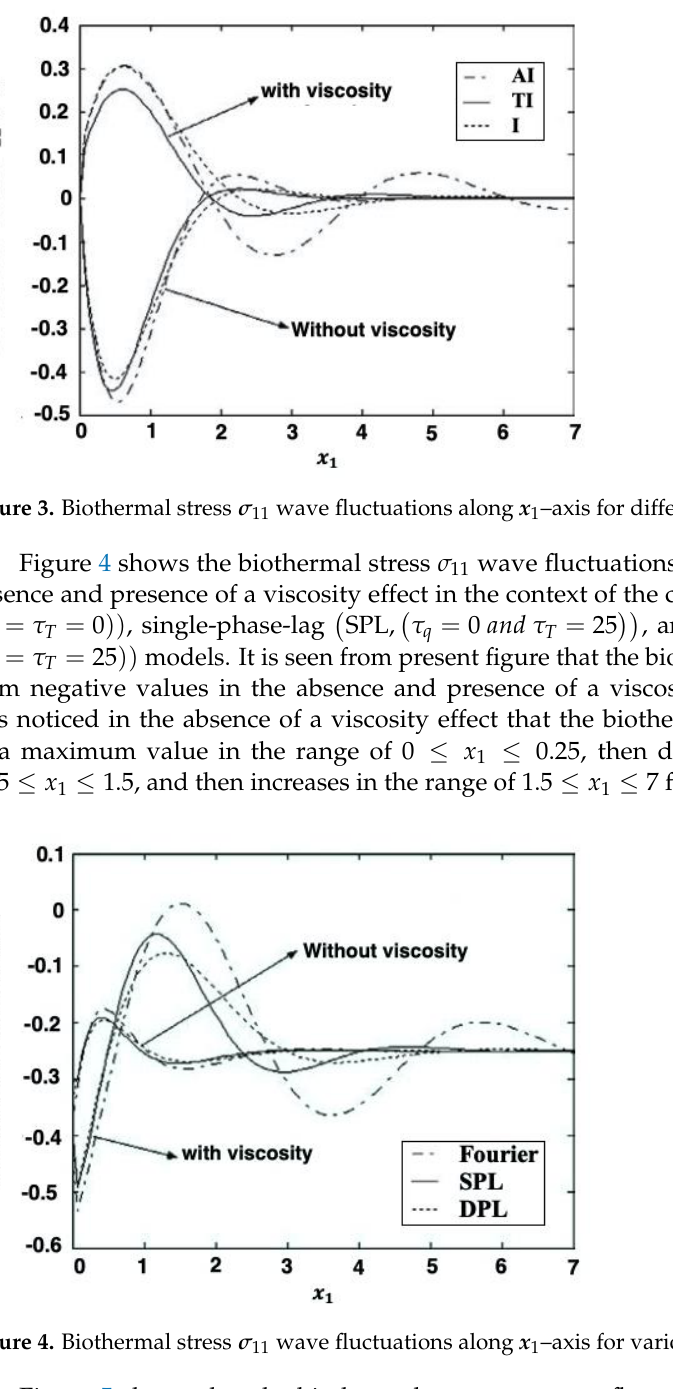
Figure 4. Biothermal stress 𝝈 𝟏𝟏 wave fluctuations along 𝒙 𝟏 – axis for various bioheat models.